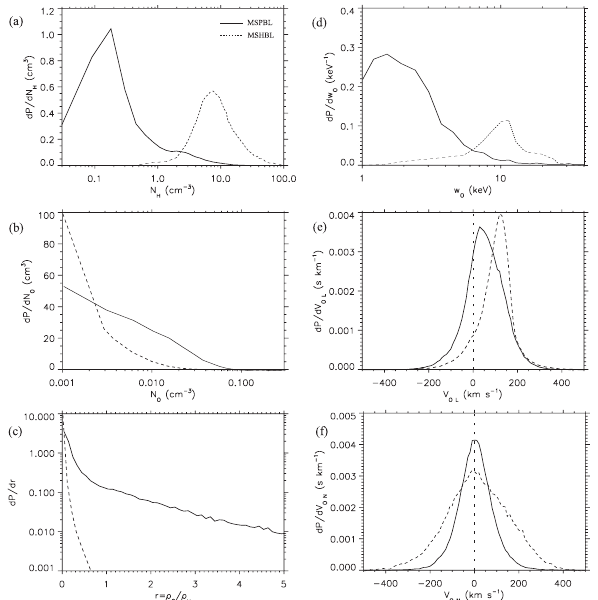
Fig. 10. Probability density functions in the magnetosheath (dot) and magnetosphere (solid) transition layers of ( a ) H + number den- sity, ( b ) O + number density, ( c ) O + /H + mass density ratio, ( d ) mean O + energy, ( e ) O + poleward velocity component, and ( f ) O + velocity component normal to the